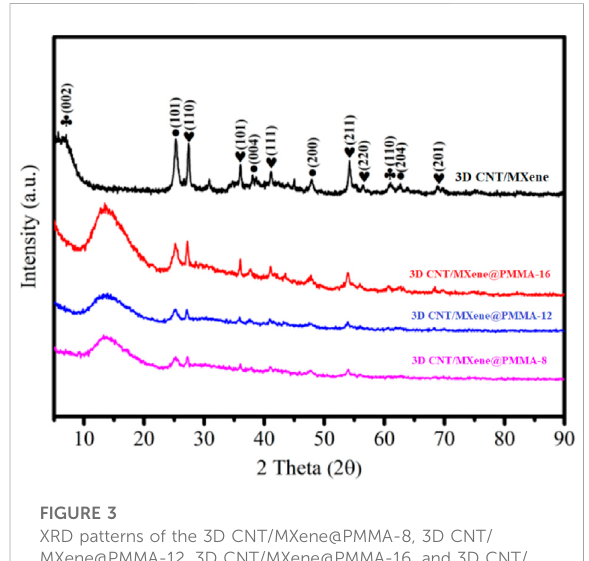
FIGURE 3 XRD patterns of the 3D CNT/MXene@PMMA-8, 3D CNT/ MXene@PMMA-12, 3D CNT/MXene@PMMA-16, and 3D CNT/ MXene composite.